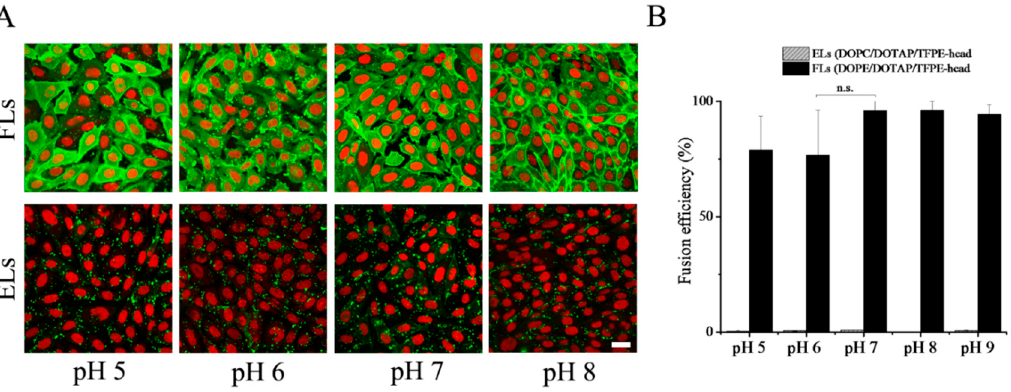
Figure 5. ( A ) Fluorescence micrographs of CHO cells after treatment with fusogenic (DOPE/DOTAP/TFPE-head, 1/1/0.1 mol/mol), upper row, and endocytic liposomes (DOPC/DOTAP/TFPE-head, 1/1/0.1 mol/mol), lower row, at different pH values. Green: TFPE-head signal, red: Nucleic staining with DRAQ5. Scale bar, 20 µm, applies to all. ( B ) Fusion efficiencies. Whiskers indicate standard deviations of at least three independent experiments.